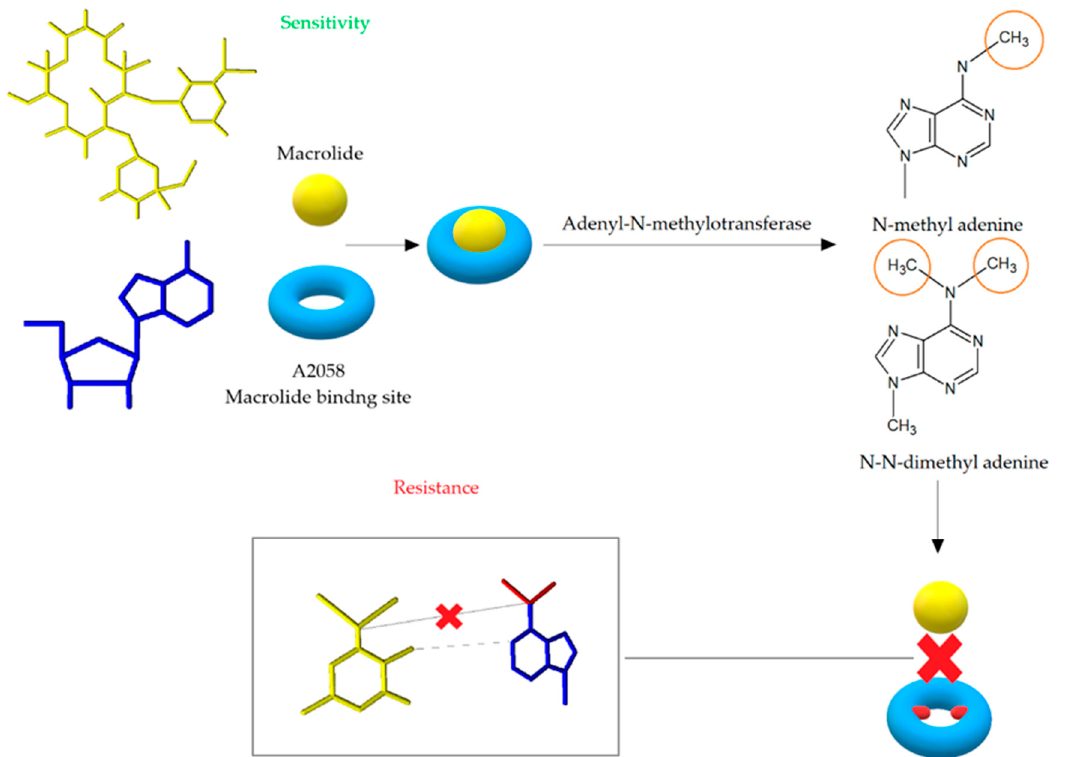
Figure 6. Modification of antibiotic’s binding site leading to cross resistance to macrolides, lincosamides, and streptogramin B. After the action of adentyl-N-methyltransferase, adenine is methylated, which prevents the binding of erythromycin to the binding site in the 50S ribosome subunit [52].